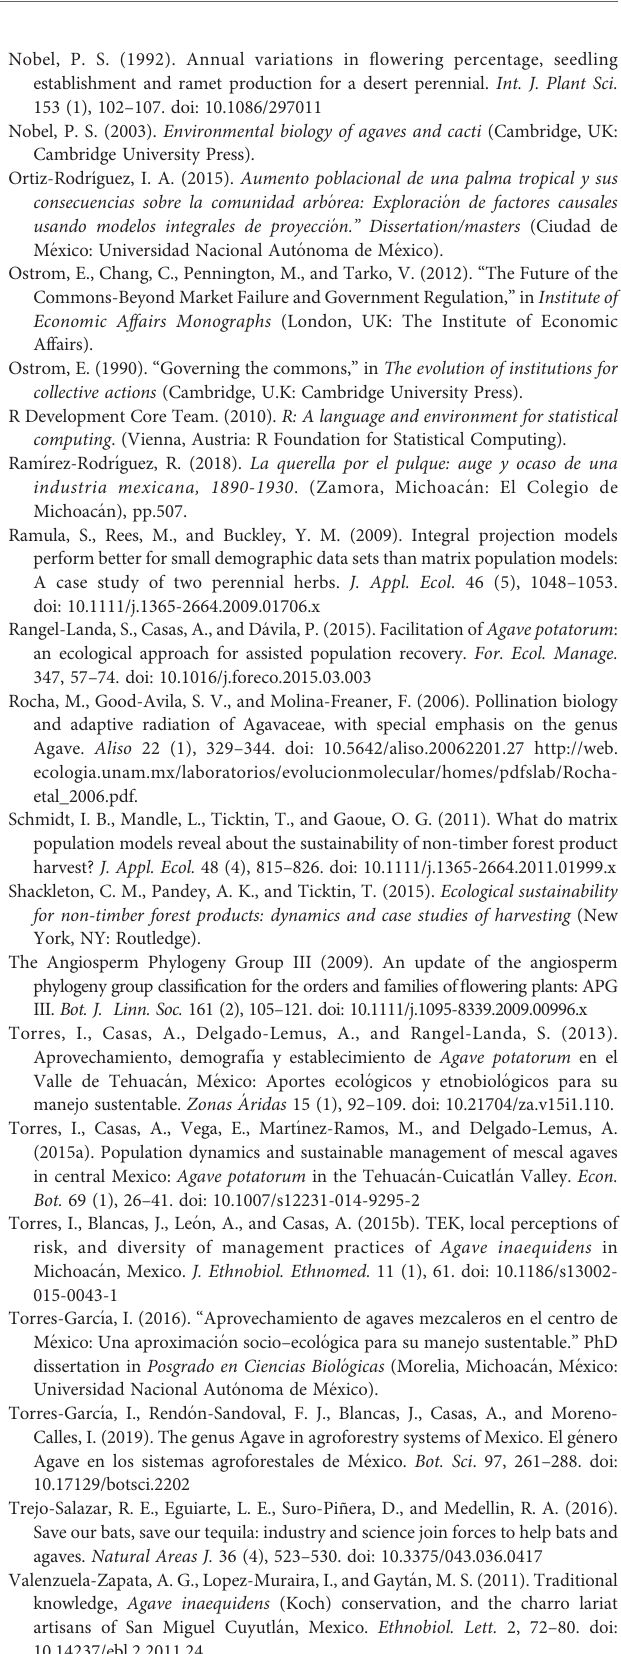
Figueredo, C. J., Casas, A., Gonza ́ lez-Rodr ı ́ guez, A., Nassar, J. M., Colunga- Garc ı ́ aMar ı ́ n, P., and Rocha-Ram ı ́ rez, V. (2015). Genetic structure